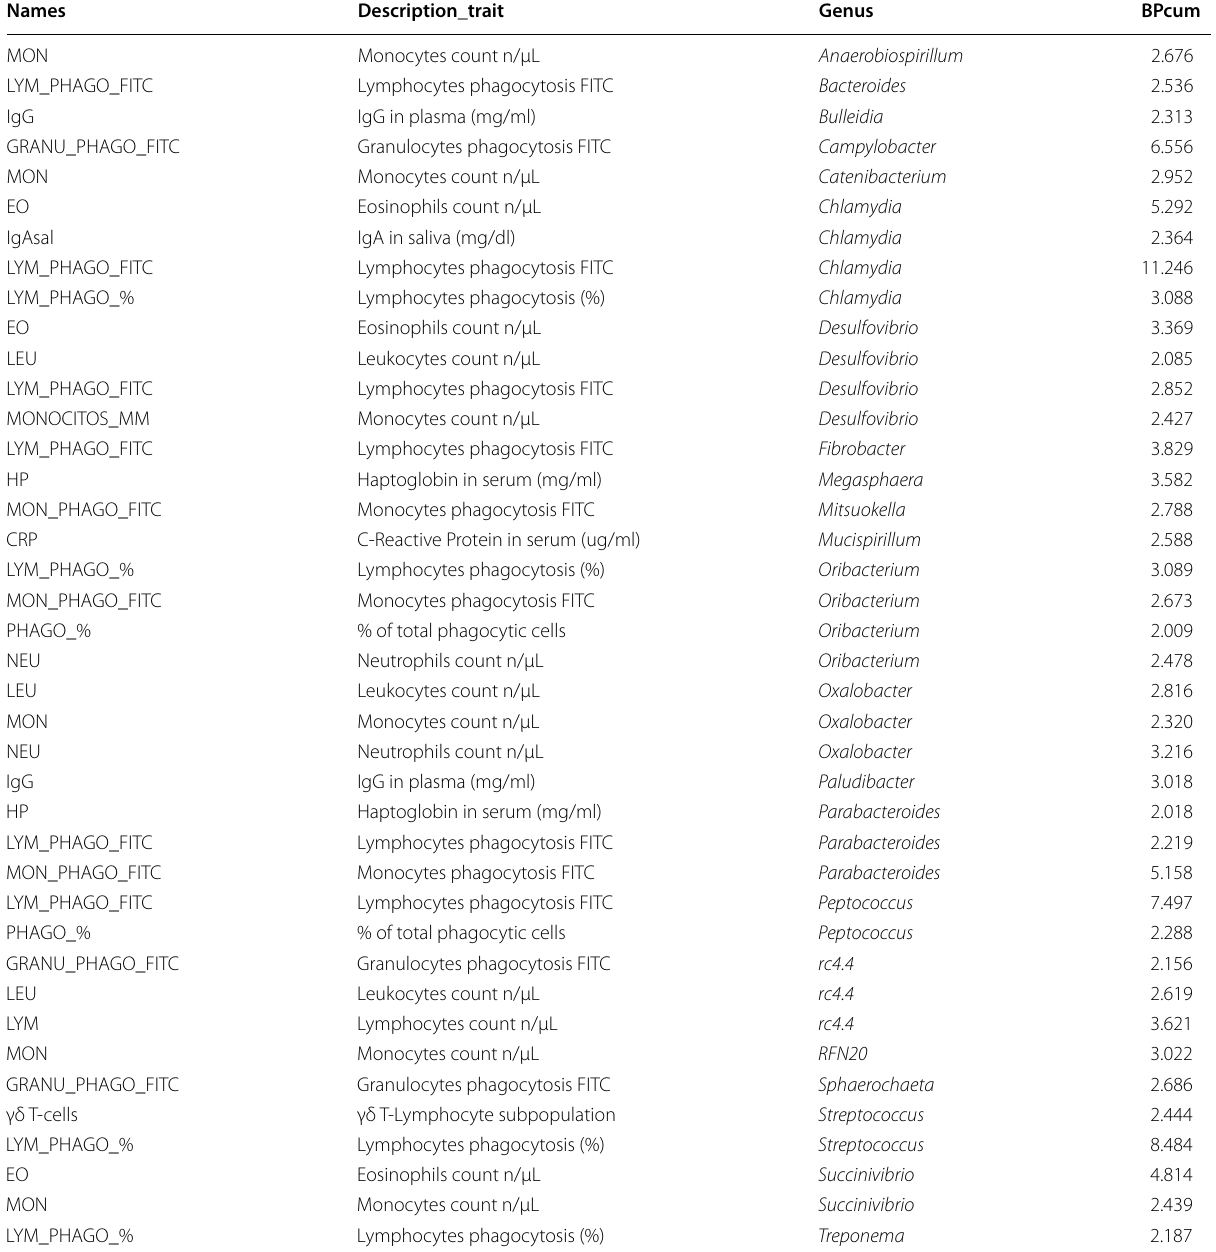
Table 2 Results from the microbial‑wide association studies